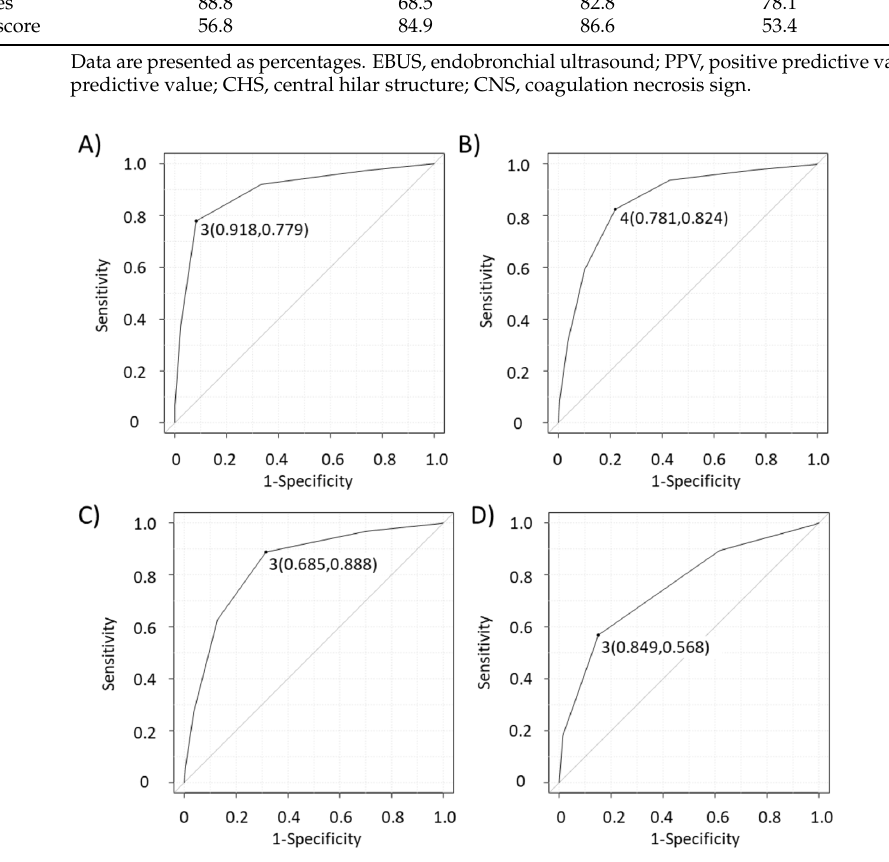
Figure 3. Discriminatory power for the prediction of malignant lymph node with novel scoring system ( A ), all eight EBUS features (B-, power/color Doppler, and elastography mode) ( B ), only six B-mode EBUS features ( C ), and the Canada lymph node score ( D ). The cut-off values derived from the receiver operating curve are 3.0, 4.0, 3.0, and 3.0, respectively. Their sensitivity and specificity for predicting malignancy are 77.9% and 91.8%, 82.4% and 78.1%, 88.8% and 68.5%, and 56.8% and 84.9%, respectively. The areas under the curve are 0.894 (95% CI: 0.868–0.92), 0.857 (95% CI: 0.826–0.889), 0.840 (95% CI: 0.807–0.873), and 0.756 (95% CI: 0.719–0.792), respectively. EBUS, endobronchial ultrasound; CI, confidence